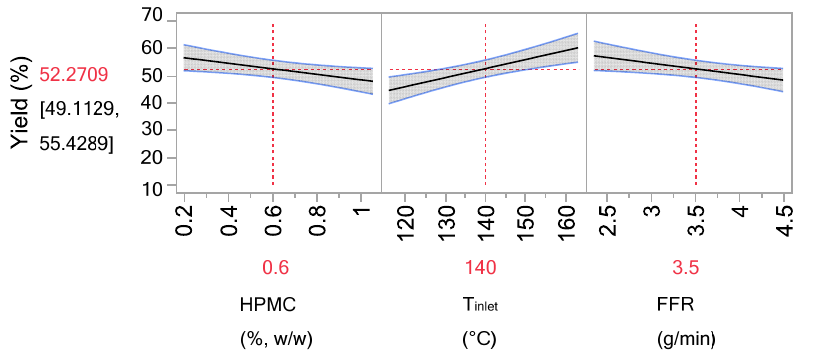
Figure 1. Prediction of yield in relation to hypromellose concentration (HPMC), inlet air temperature ( T inlet ) and feed flow rate (FFR). Values in brackets refer to 95% confidence interval.